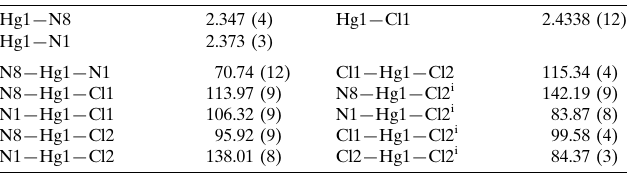
Selected geometric parameters (A˚ , (cid:3)